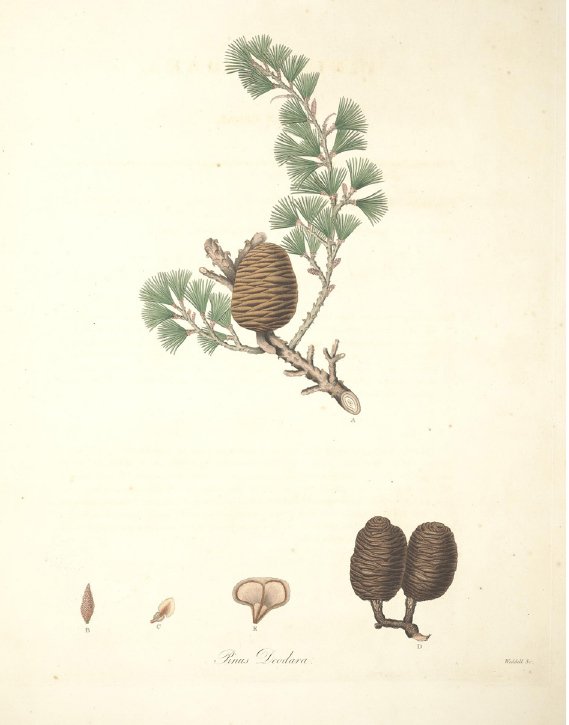
Image 2. Lectotype of Pinus roxburghii : Lambert’s Tab. XXI “Pinus longifolia”.